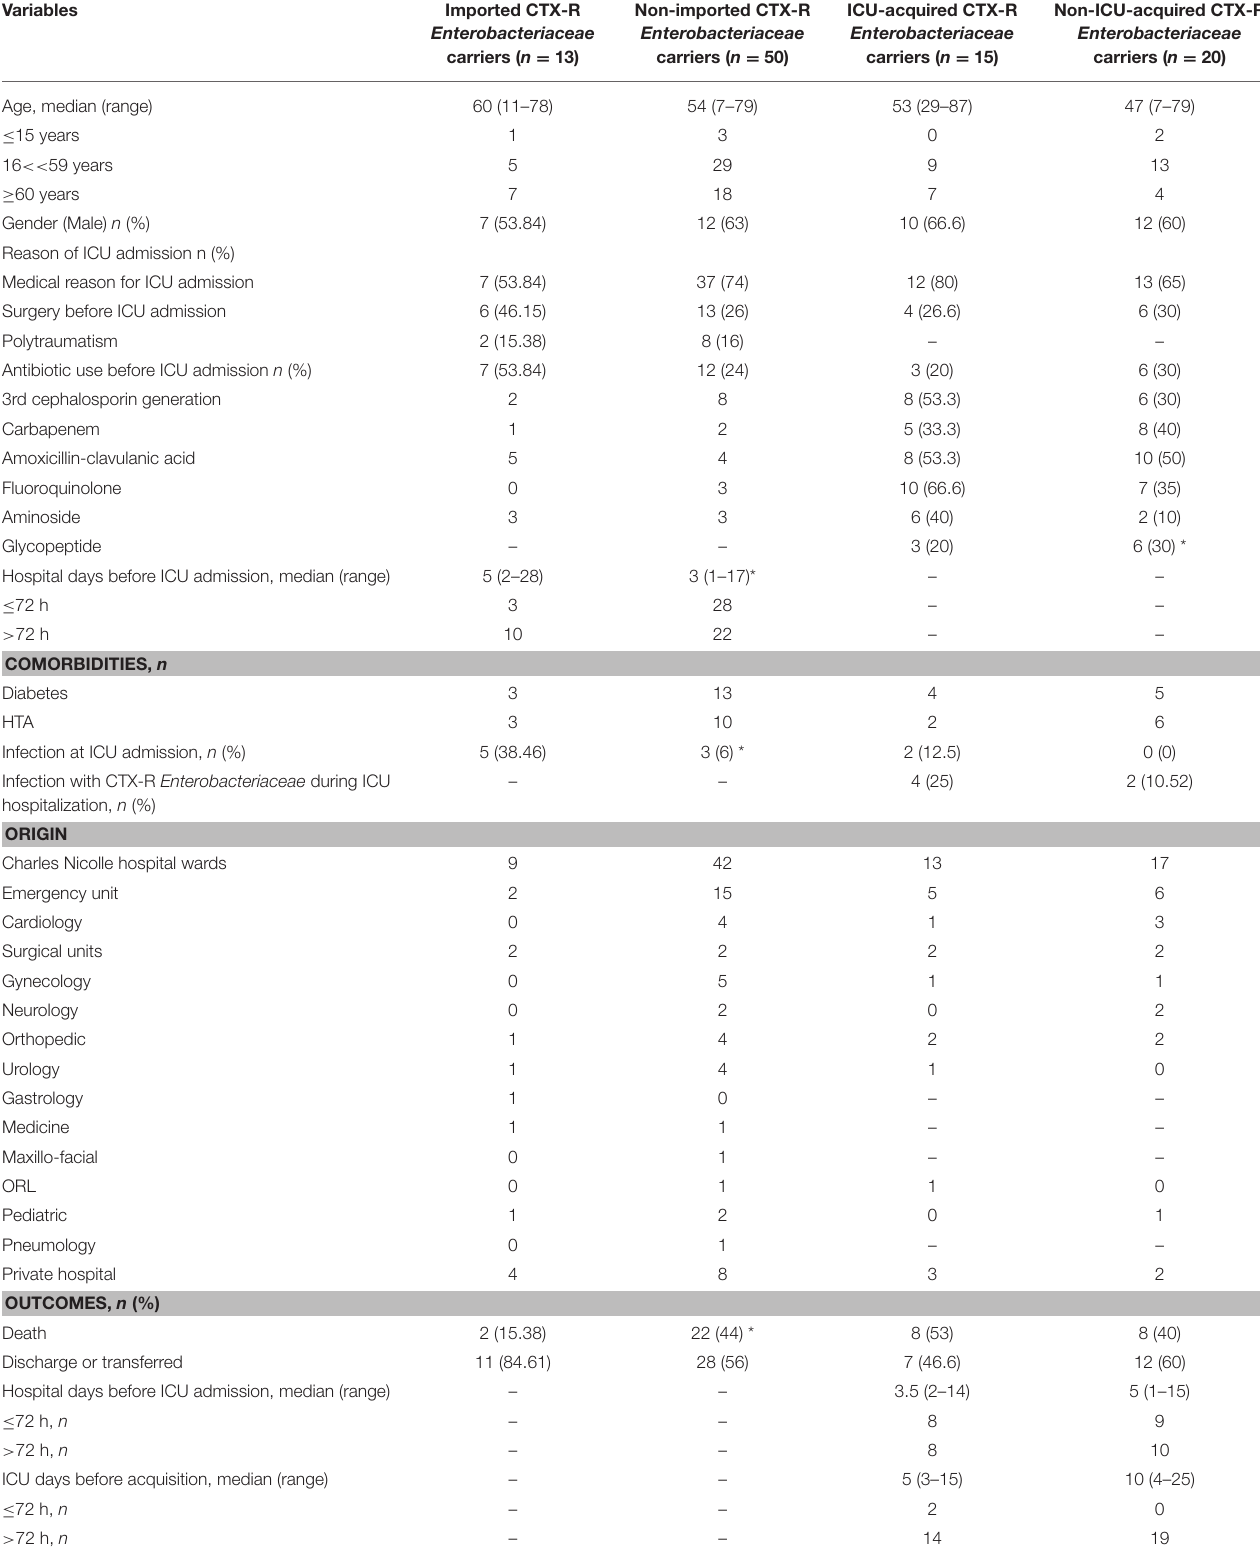
TABLE 1 | Characteristics of patients with cefotaxime-resistant Enterobacteriaceae in fecal carriage at ICU admission and during ICU hospitalization.